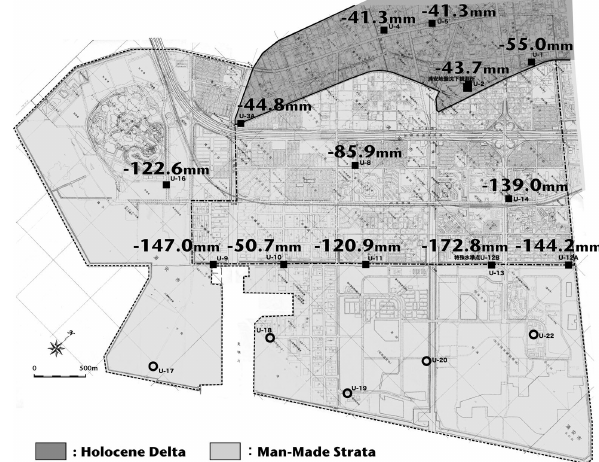
Figure 3. Elevation change of bench marks in Urayasu City (January